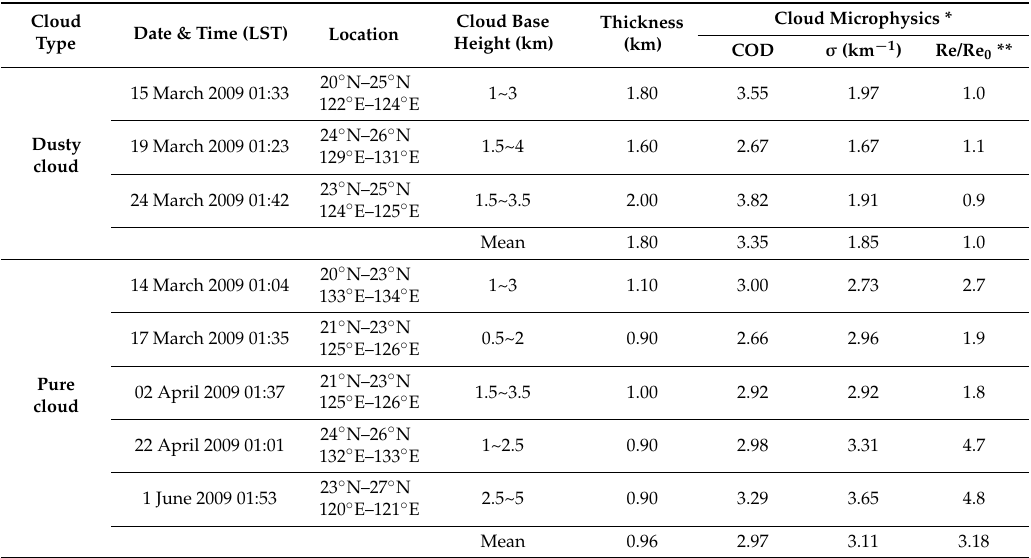
Table 1. Comparison of the cloud microphysics between dusty water cloud and pure water cloud at low altitudes over the